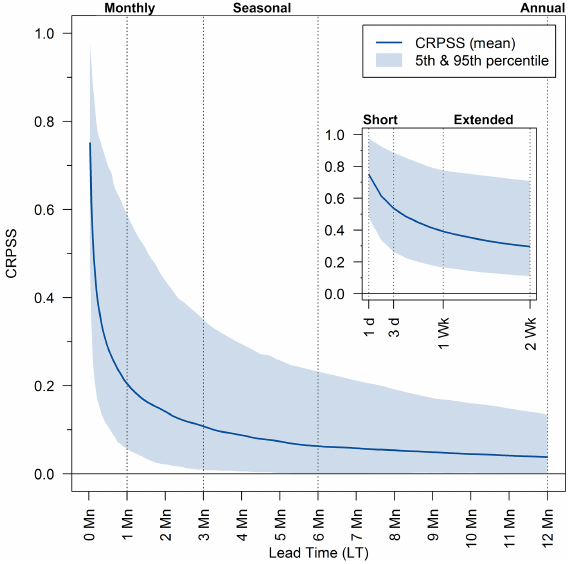
Figure 3. UK-wide mean ESP CRPSS values across all 314 catch- ments and 12 forecast initialization months for all 365 lead times (LTs) with short and extended lead times also shown inset for read- ability. The range of skill scores across catchments at each LT is shown by the semi-transparent 5th and 95th percentile band. Ver- tical lines represent eight commonly used operational forecasting LTs from short (1 and 3 days), extended (1 and 2 weeks), monthly (1 month), seasonal (3 and 6 months), to annual (12 months).